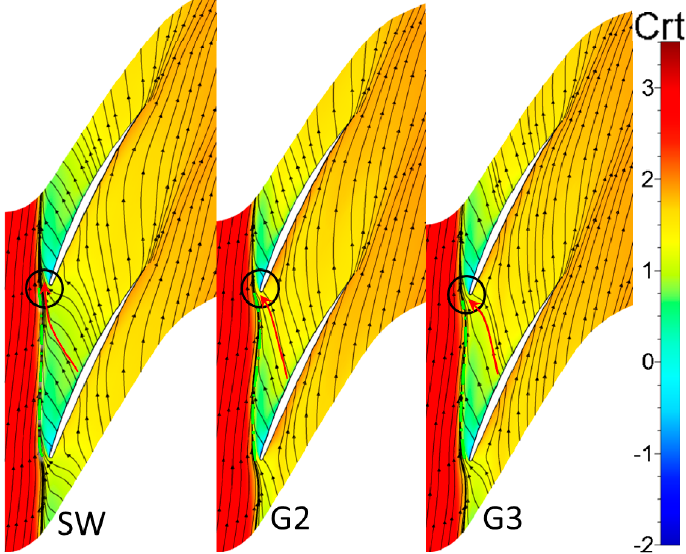
Figure 8. Time-averaged surface streamlines and relative total pressure coefficient contours on the blade tip plane in different